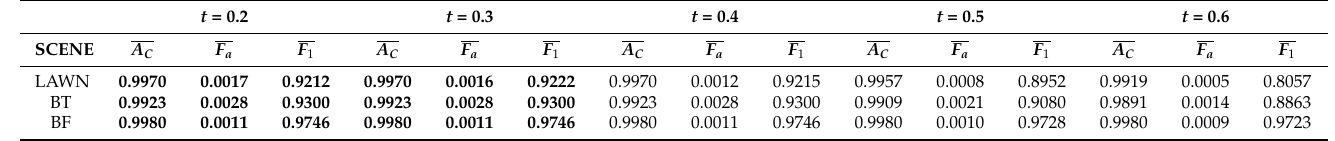
Table 3. Experimental results with different parameters t . The best results are